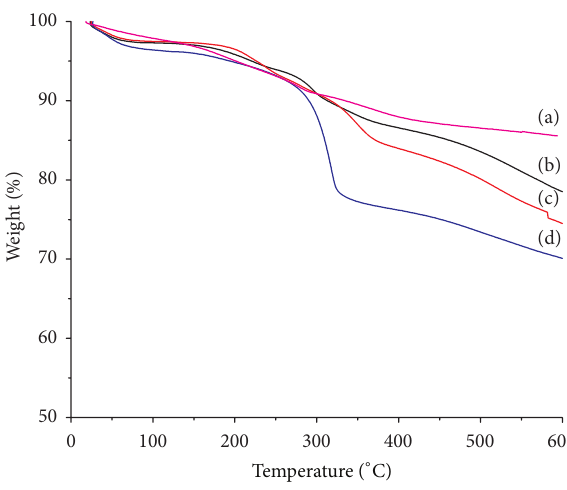
Figure 2: XRD patterns of pure PANI (a), CNT/PANI composites prepared in HCl (b) and HNO 3 (c) medium, and CNT-COOH (d).